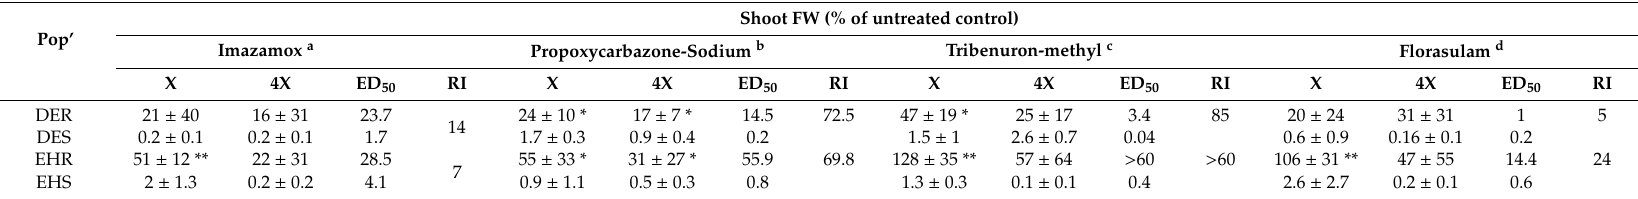
Table 3. E ff ects of post-emergence treatments on the shoot fresh weight (FW) of plants from D. erucoides (DES) and E. hispanica (EHS) ALS-sensitive and -resistant populations (DES, D. erucoides (DER), EHS, and E. hispanica (her), respectively). Herbicides were applied at 1 and 4 times the label field rate (X). Shoot FW (% of untreated control) Pop’ Imazamox a Propoxycarbazone-Sodium b Tribenuron-methyl c Florasulam d X 4X ED 50 RI